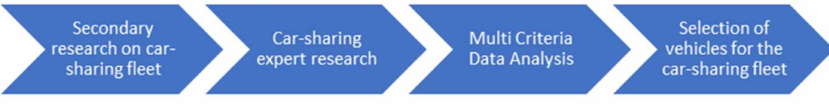
Figure 1. Research